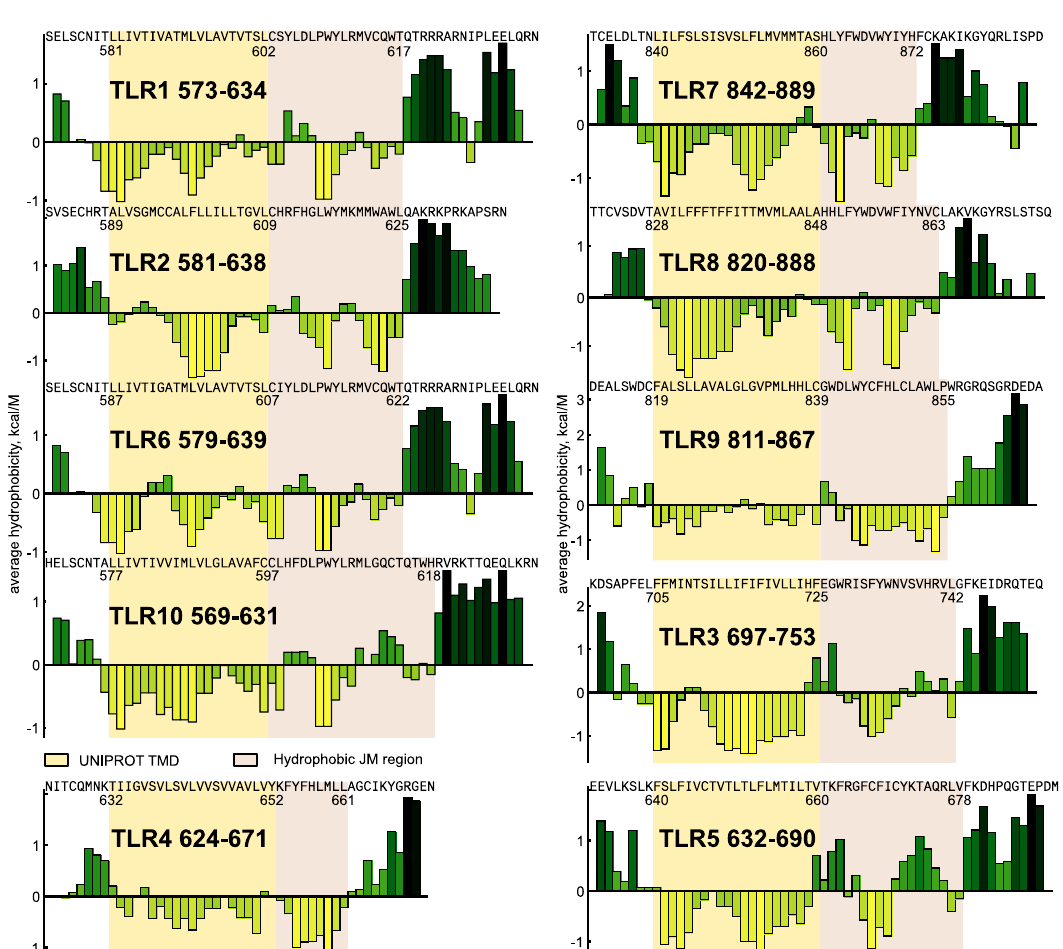
Fig. 1 | Hydrophobic properties of TLR juxtamembrane residues. The moving averagehydrophobicity(theframeequalsfouraminoacids)isshownfortheTMDs andJMpartsofallhumanTLRs.Barsarecoloredwithrespecttothehydrophobicity values: yellow for hydrophobic, and dark green for hydrophilic. All sequences are taken starting from the 8th residue prior to the predicted TMDs and fi nishing with